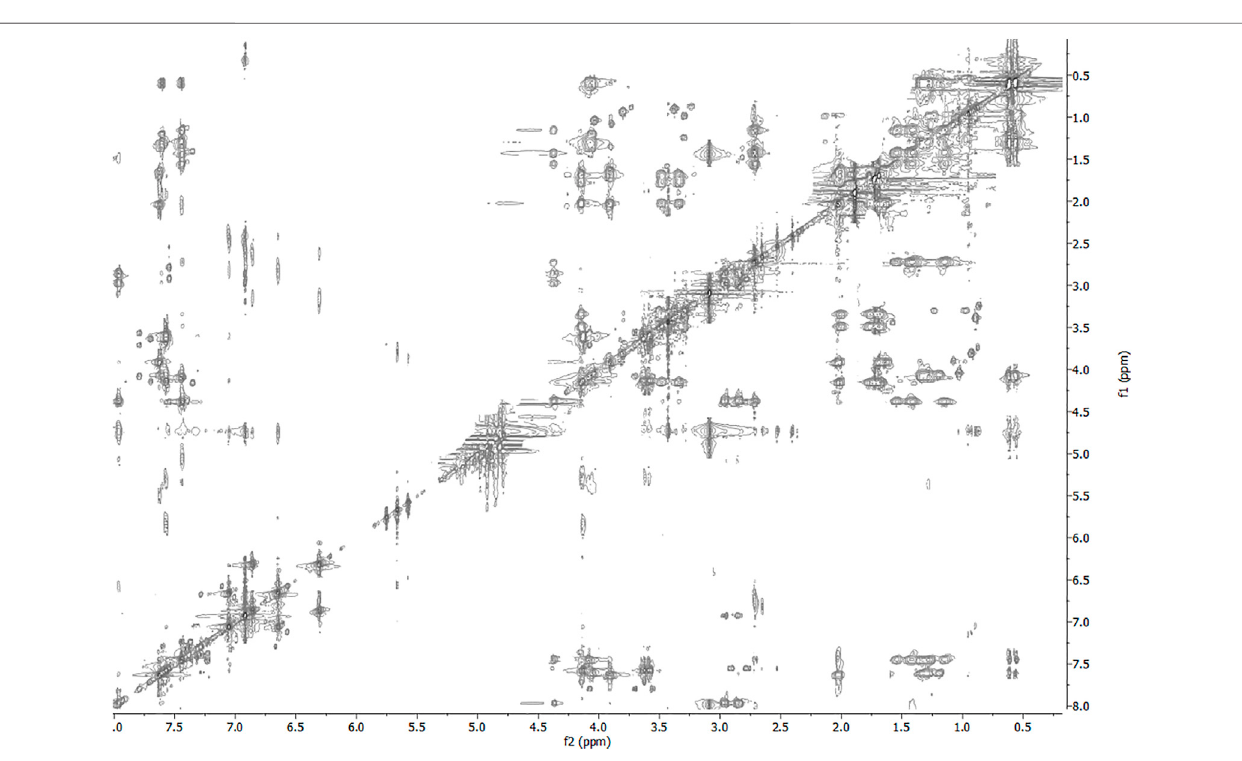
Frontiers in Molecular Biosciences |